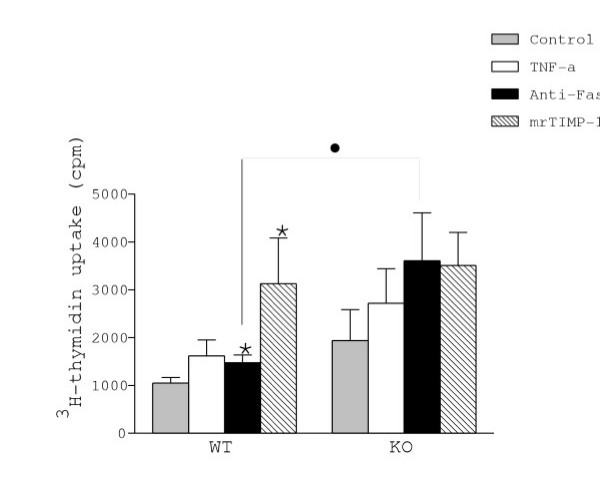
Astrocyte proliferation was estimated by measuring 3H-thymidin uptake, expressed in cpm. Note that constitutive uptake was higher in KO than in WT astrocytes. Both anti-Fas antibody and mrTIMP-1 increased proliferation of WT astrocytes but not of KO astrocytes. Values represent the mean +/- s.e.m. of at least three independent experiments. Statistical differences were determined by Student's t test when comparing treatments to control cells with the same genotype (* p < 0.05) or KO vs WT cells (● p < 0.05).